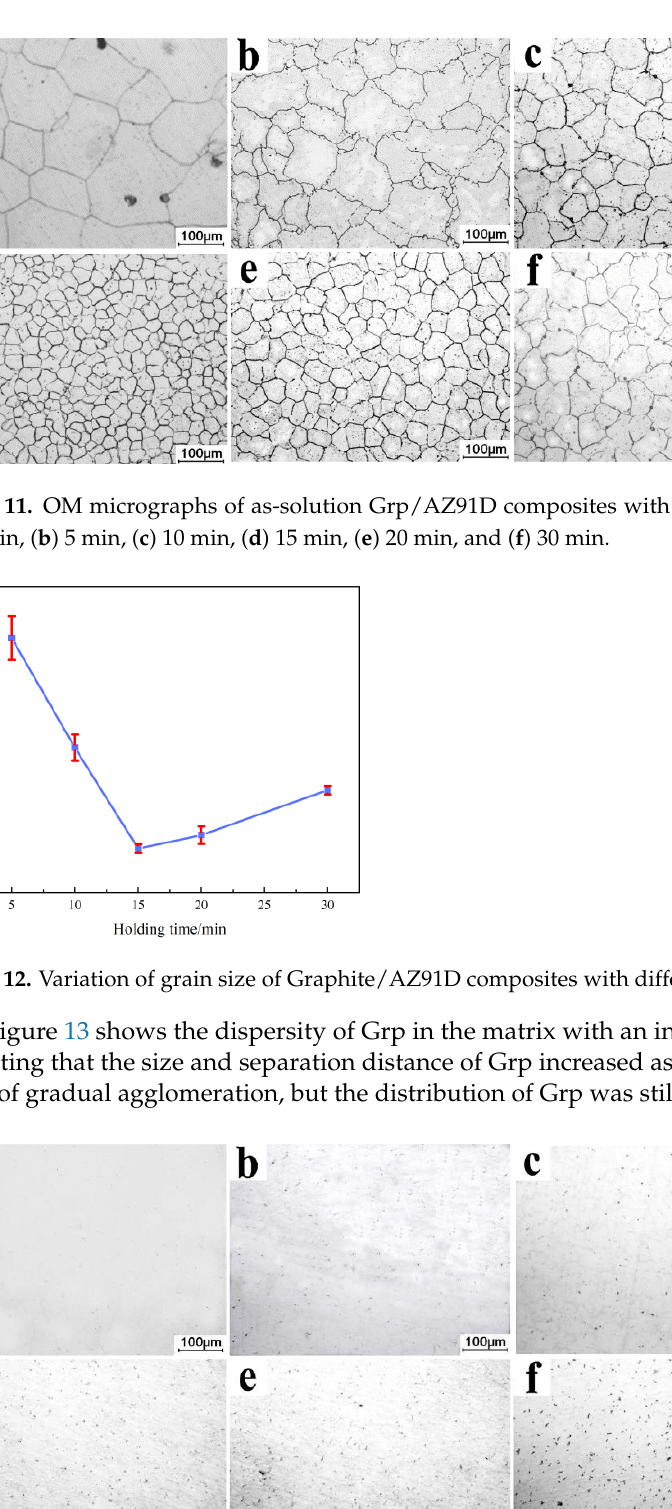
Figure 13. The dispersity of Grp with different holding times: ( a ) 0 min, ( b ) 5 min, ( c ) 10 min, ( d ) 15 min, ( e ) 20 min, and ( f ) 30 min.